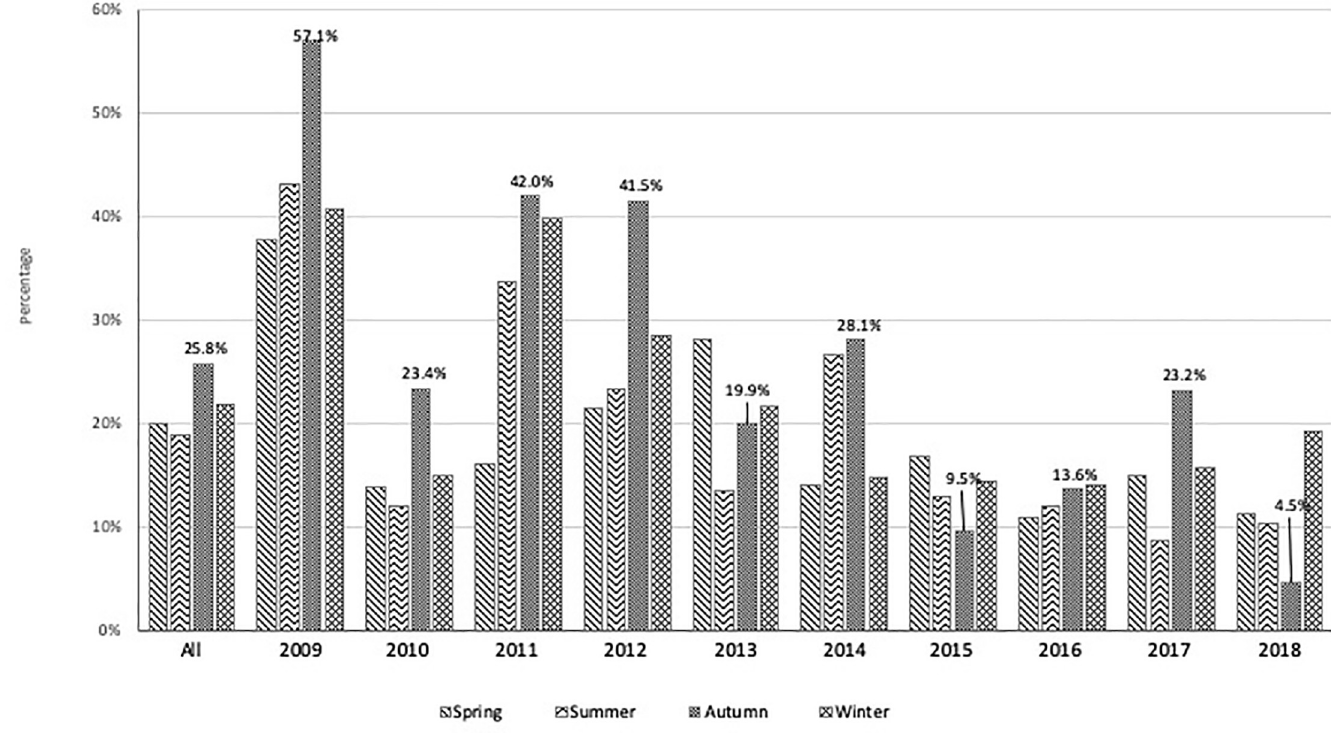
Fig 3. Seasonal frequency of residents with detectable levels for all data set and each year. The increased percentage in autumn was significant in 6 out of 10 years (p < 0.05). Winter had the second highest rate of frequency of people with detectable contamination, though only the increase in three years (2009, 2014, 2018) was